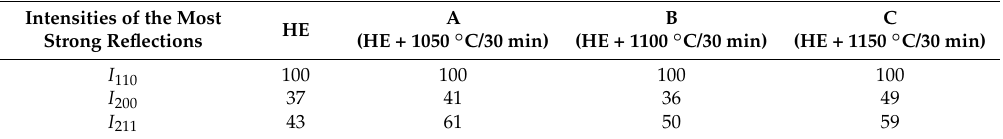
Table 2. Intensities (normalized to 100) of the most strong reflections in the XRD spectra of hot extruded material (HE), and hot extruded plus heat treated at 1050 ◦ C (A), 1100 ◦ C (B), and 1150 ◦ C (C) for 30 min. extruded material (HE), and hot extruded plus heat treated at 1050 °C (A), 1100 °C (B), and 1150 °C (C) for 30 min.